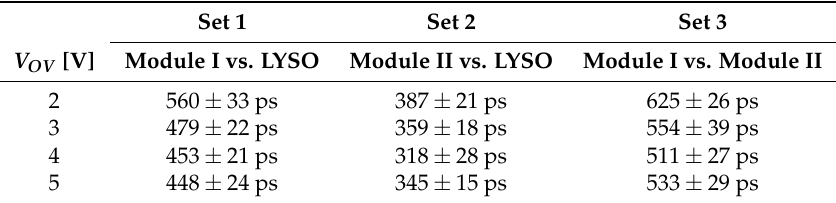
Table 3. The measured coincidence time resolution: Each value is the mean coincidence time resolution (CTR) of multiple pixel pairs in that configuration and the uncertainty is the standard deviation of the measured